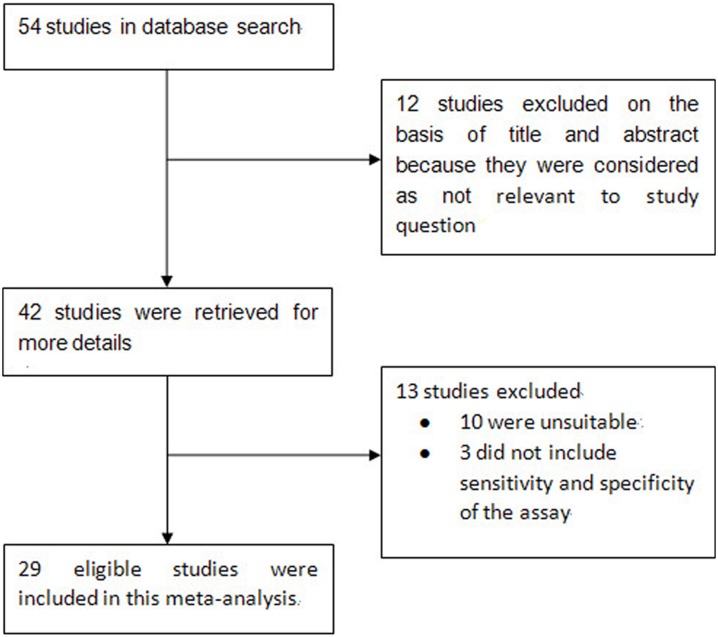
Flow chart of selection process for eligible articles.